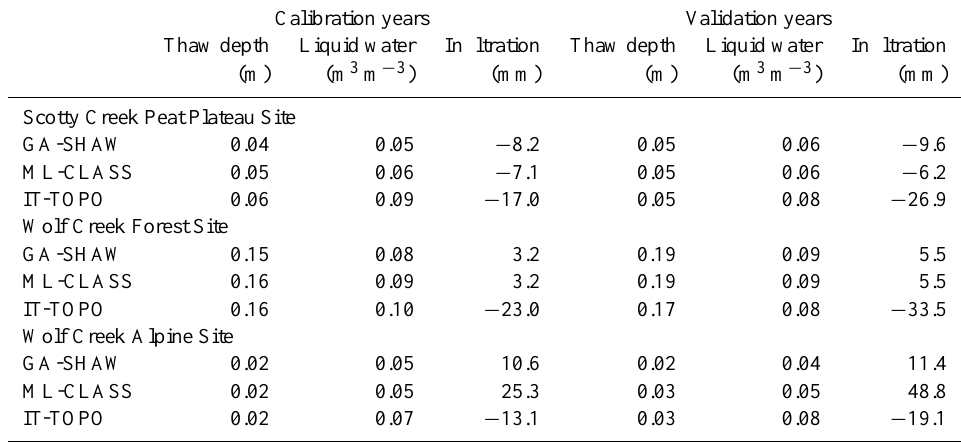
Table 7. The root mean squared differences of daily thaw depth and liquid water content, absolute difference of cumulative infiltration between observation and simulation by three algorithms at three testing sites during both calibration and validation